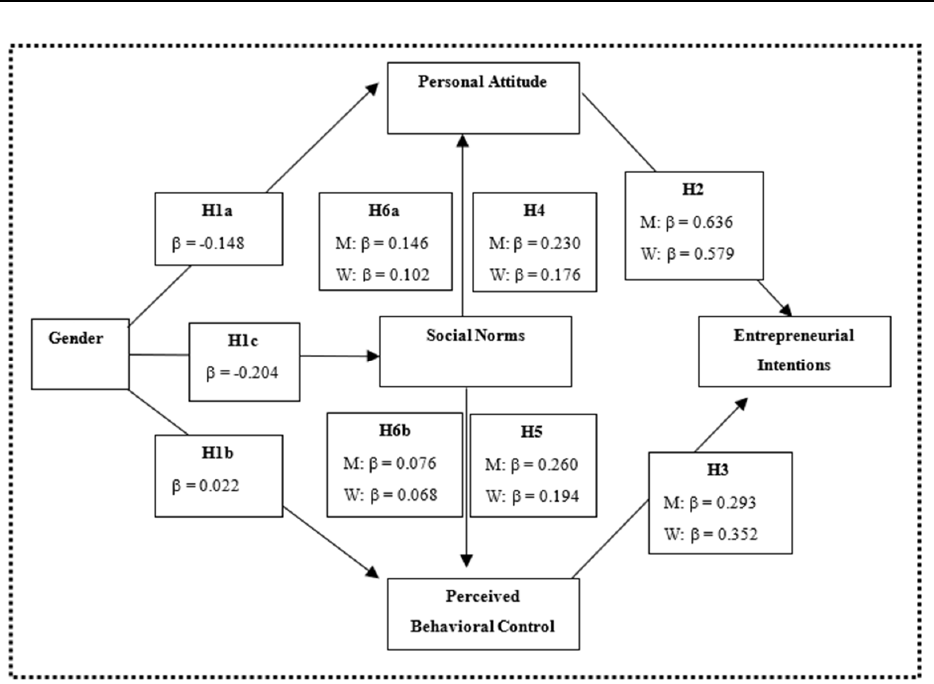
Figure 8. Summary of the coefficients obtained in the estimation of the hypotheses. Note: M = Men; W = Women. Table 7. Summary of hypotheses.